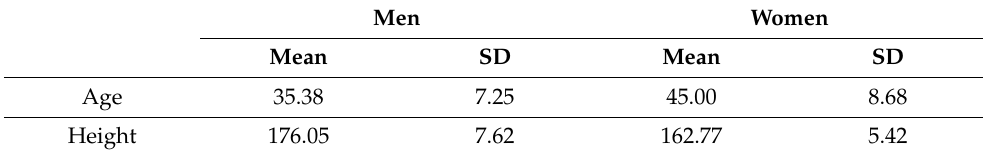
Table 3. Descriptive statistics (mean ± SD) of the sample separated by sex. Men Women Mean SD Mean SD Age 35.38